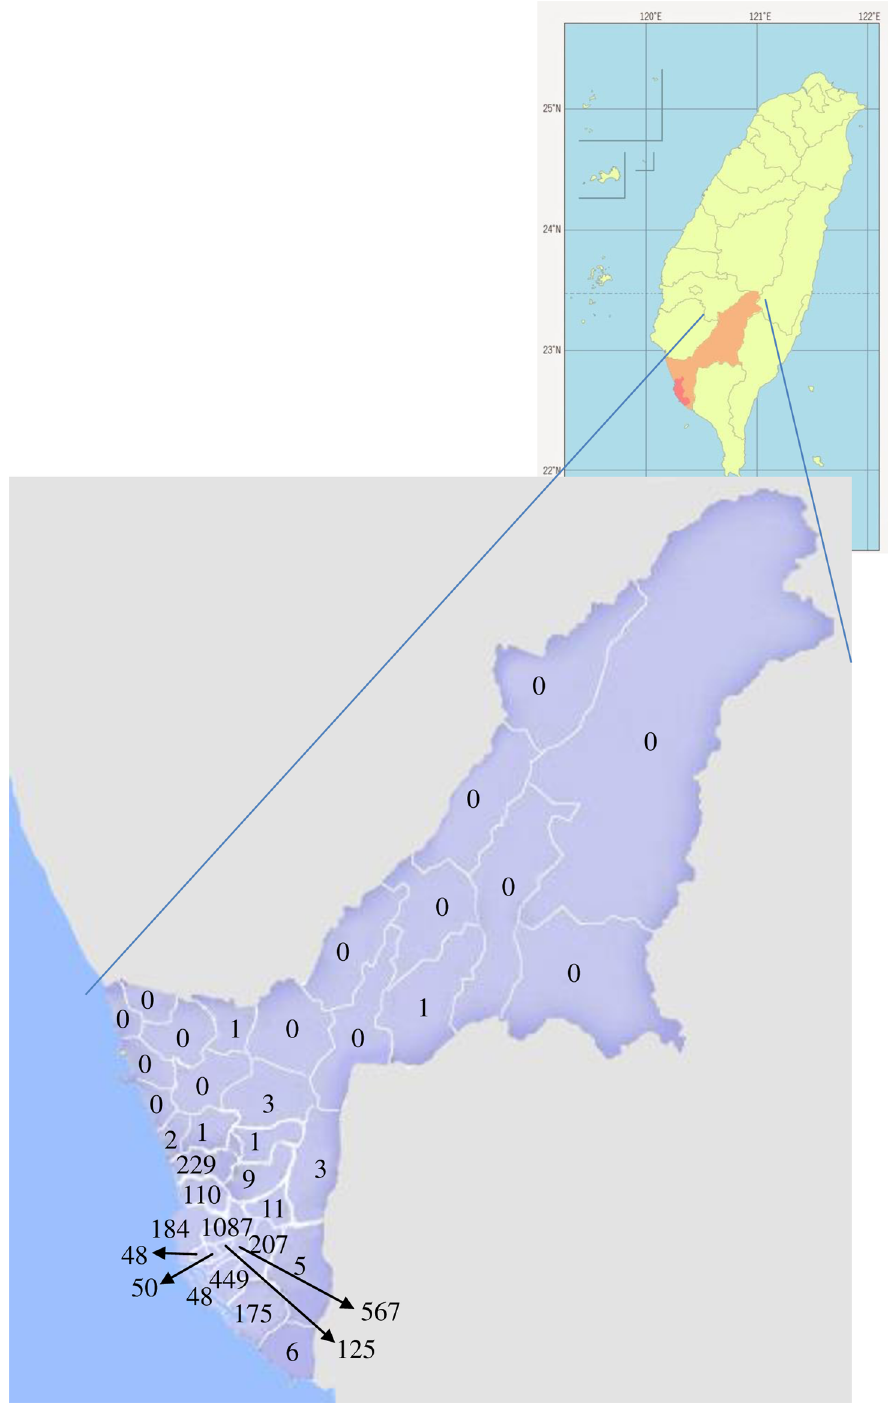
Fig 1. The spatial distribution of dengue patients in Kaohsiung City, Taiwan during 2007–2011.